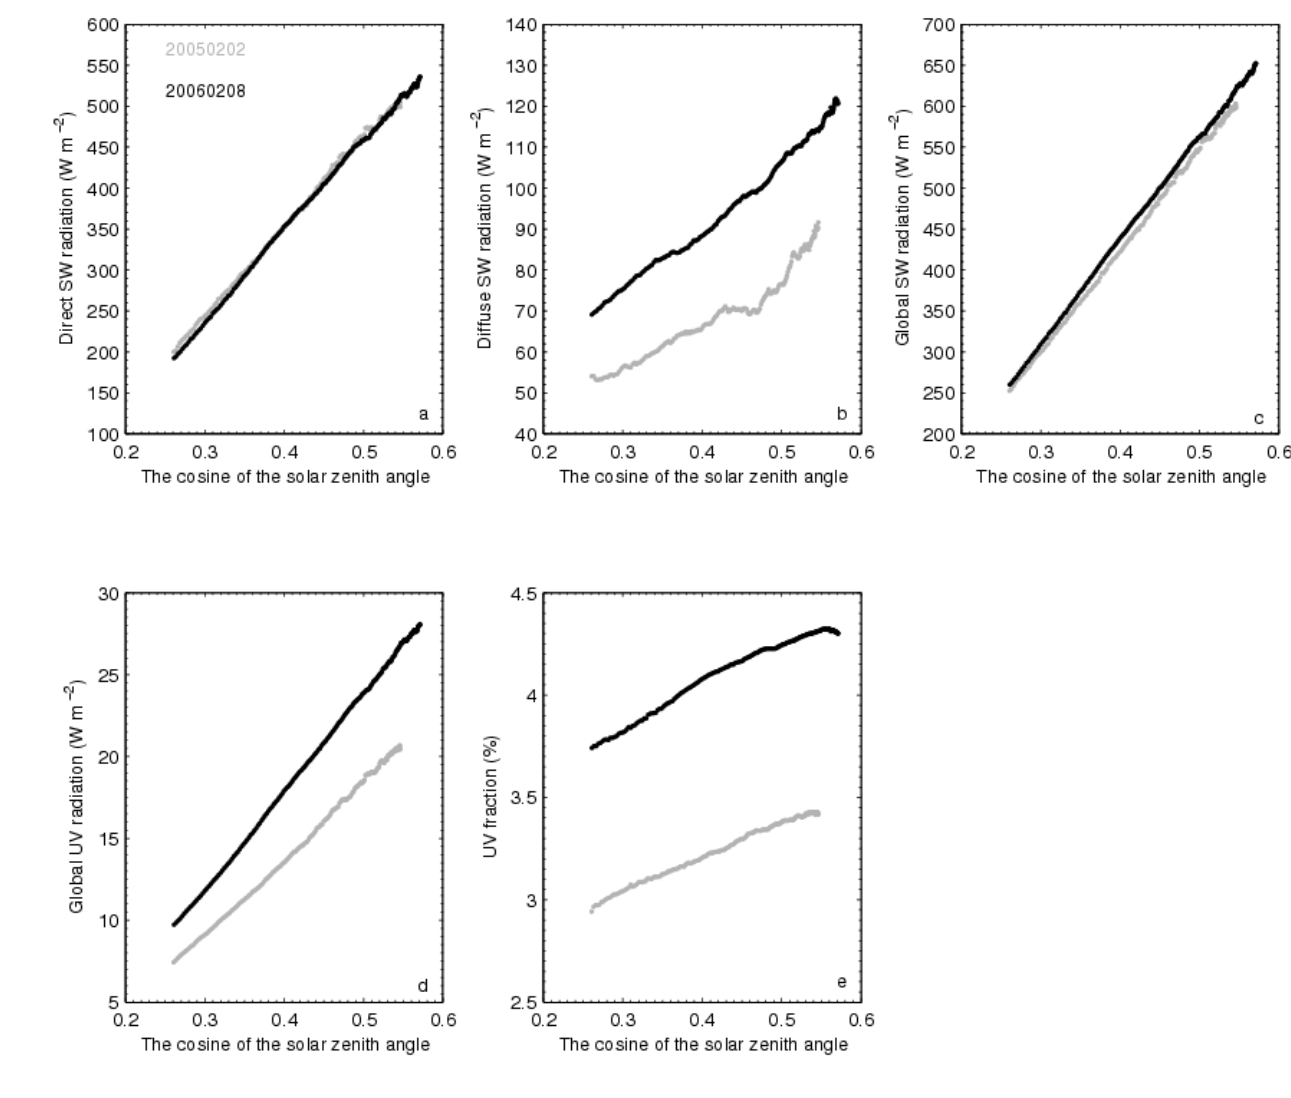
4 A clear-sky model of UV between two days: February 2, 2005 and February 8, 2006. The attenuation of solar